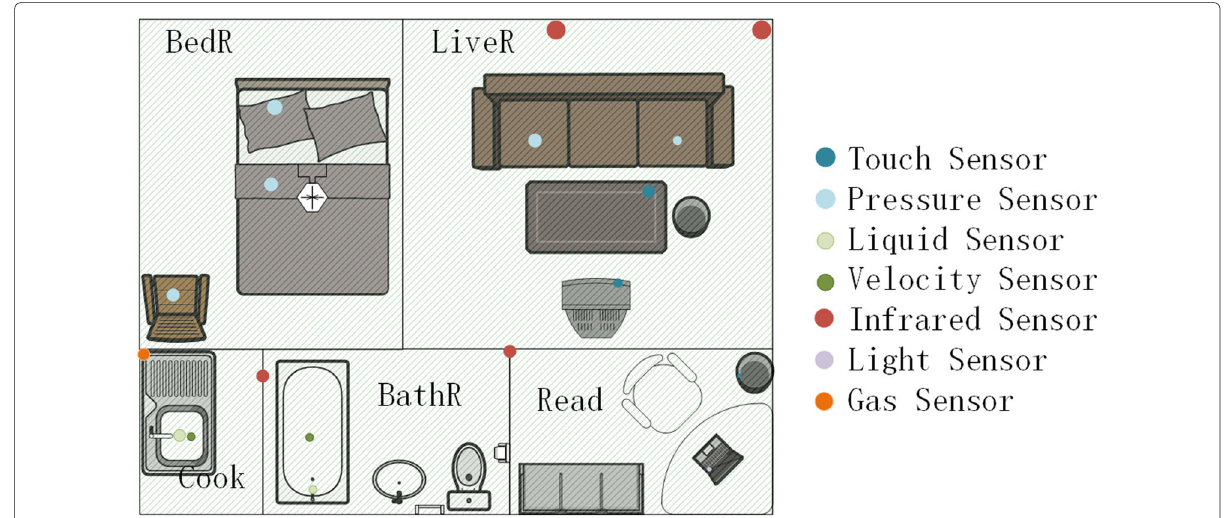
Fig. 7 Hierarchical methodology for sensor, entity, and